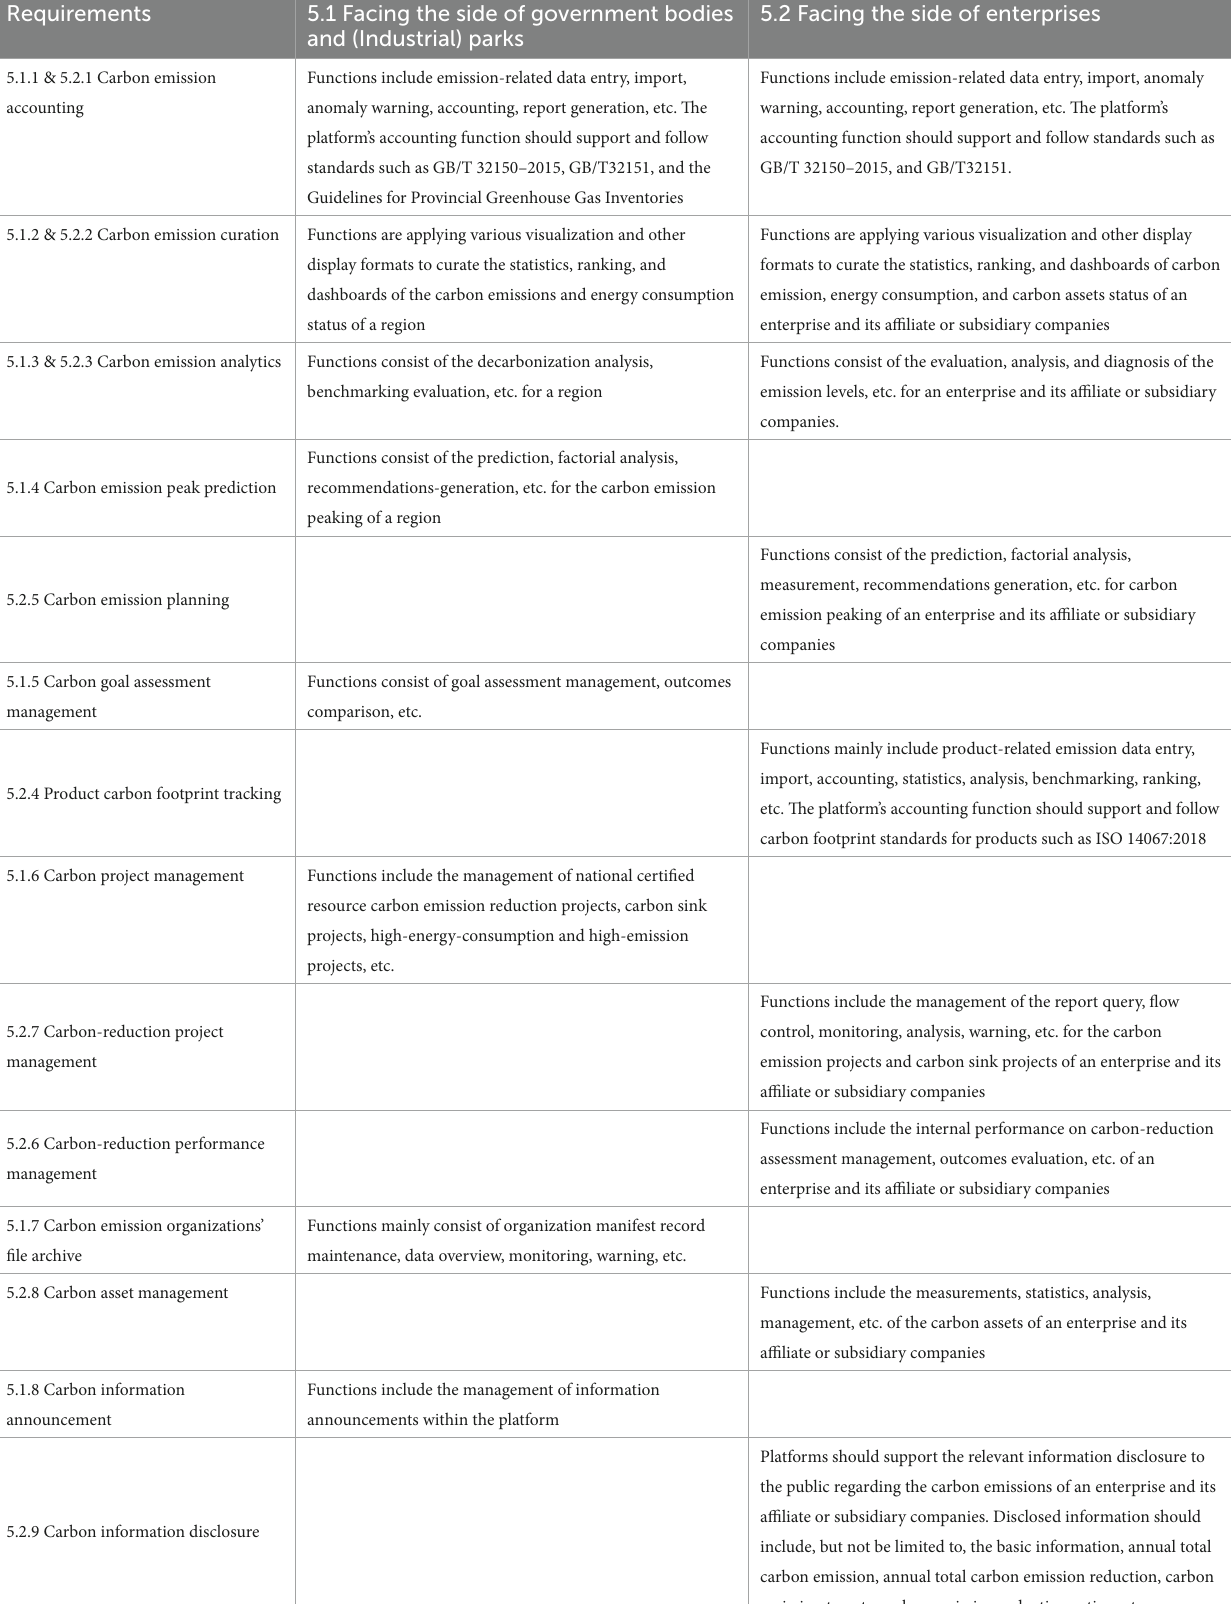
TABLE 2 Functional requirements of China’s “Carbon Peak Carbon Neutral Management and Service Platform.”